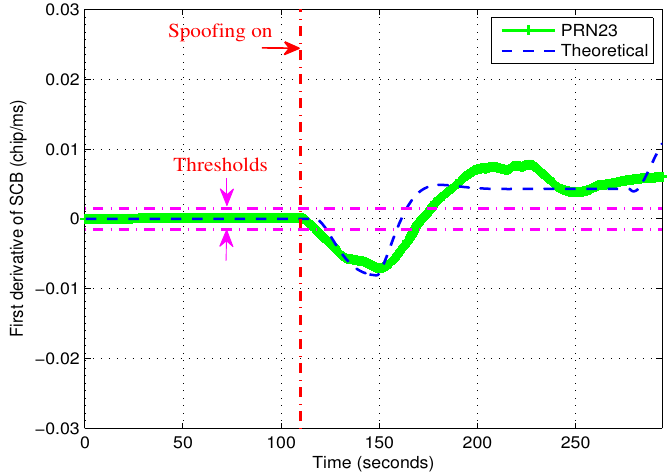
Figure 6. The first derivatives of experimental and the theoretical SCB curves for PRN 23. Table 1. The relationship between false alarm probability and detection threshold for the proposed algorithm. False Alarm Probability (%)